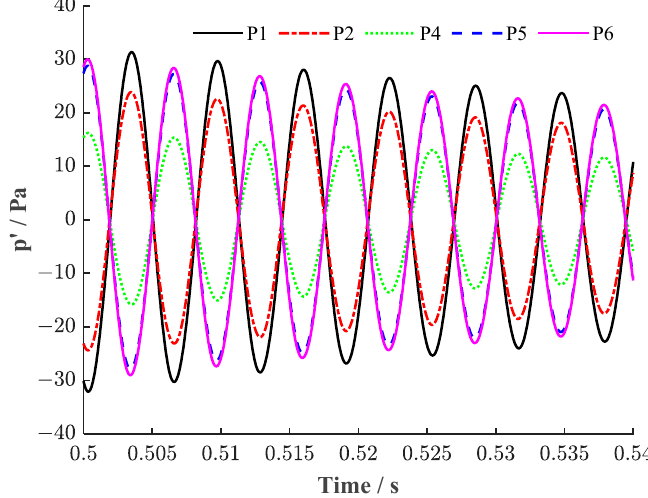
Figure 5. Phase difference of different monitoring points.